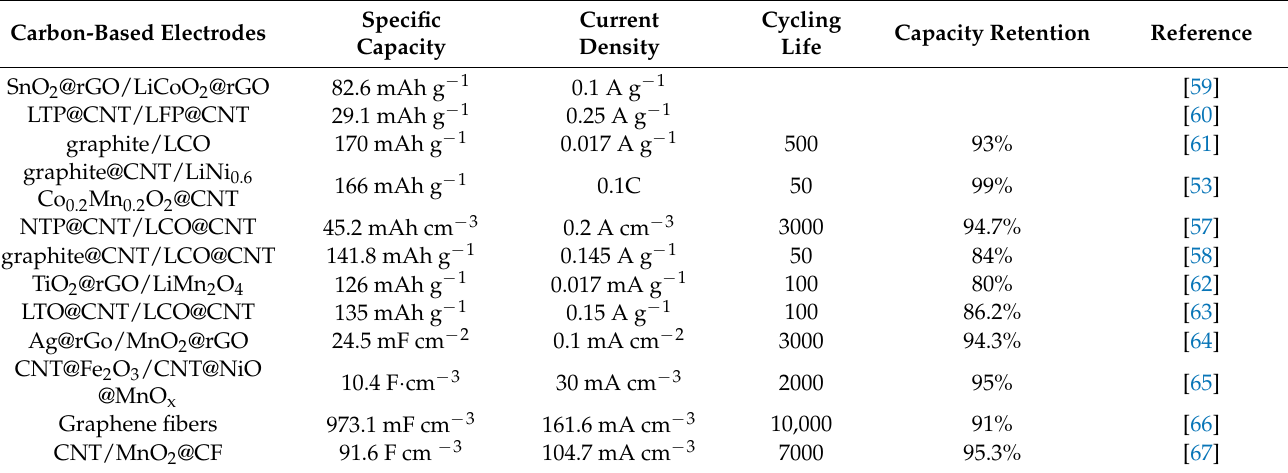
Table 1. The performance of reported 1D fiber-shaped